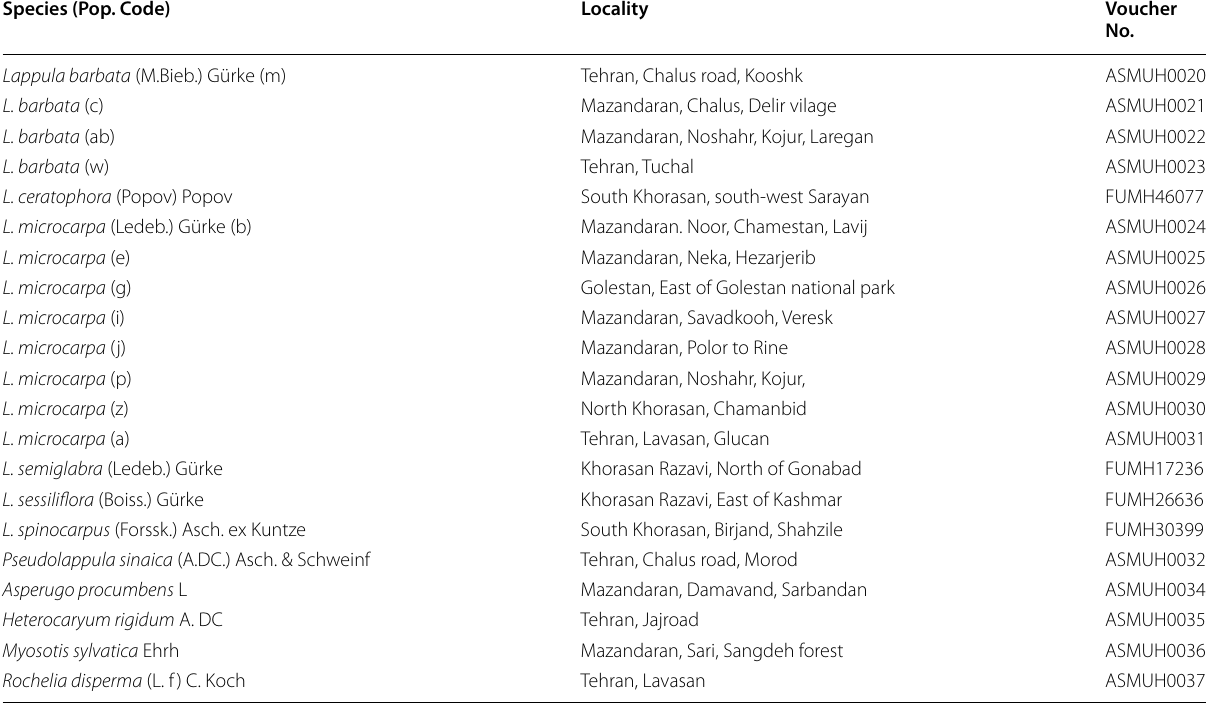
Table 1 List of sampled taxa, locality and their vouchers numbers Species (Pop.